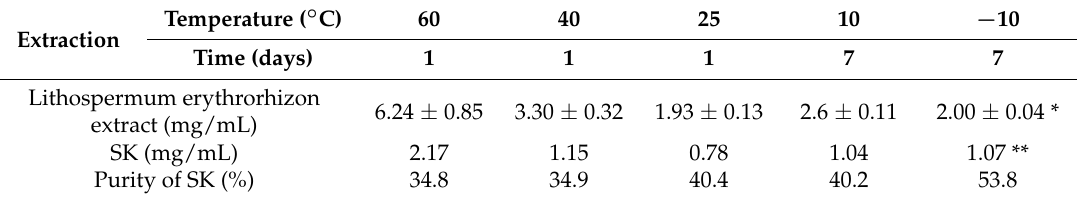
Table 1. Effects of extraction temperature on the concentration of shikonin